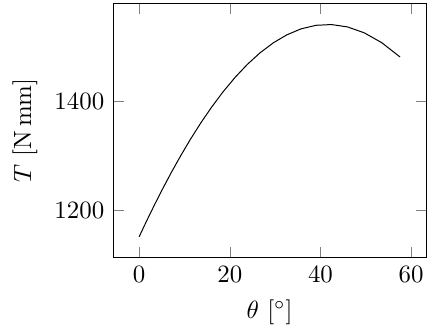
Figure 3. Nonlinear, softening, spring response obtained from VRD